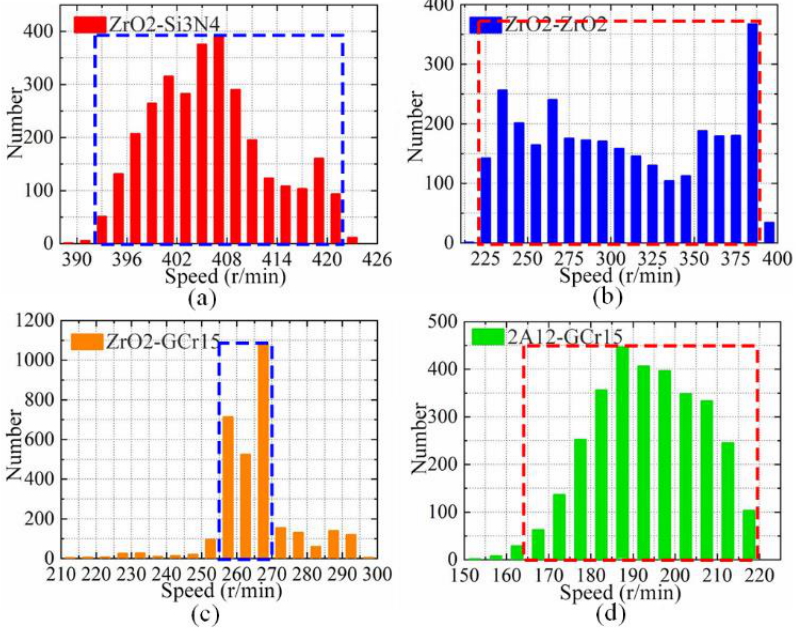
Figure 6. Statistical histogram of the output velocity of different friction pairs: ( a ) ZrO 2 -Si 3 N 4 ; ( b ) ZrO 2 -ZrO 2 ; ( c ) ZrO 2 -GCr 15 ; ( d ) 2A12-GCr 15 .